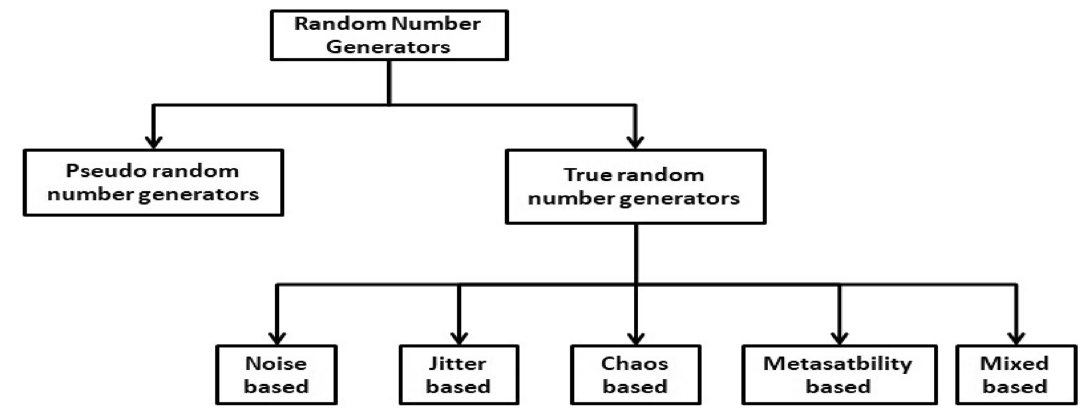
Fig. 1 Classification random number generators